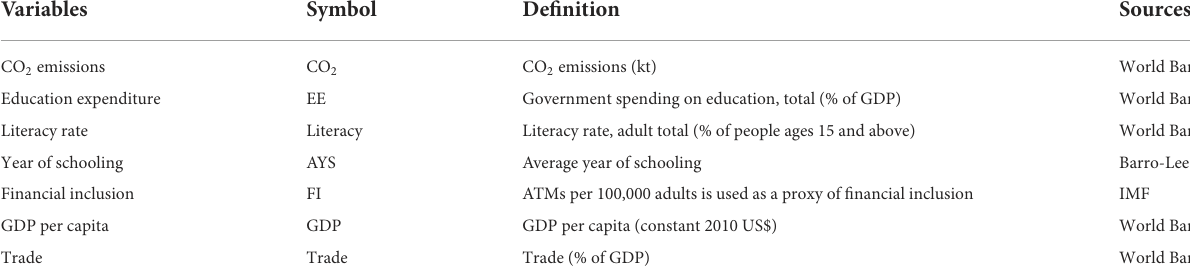
TABLE 1 Definitions and sources.